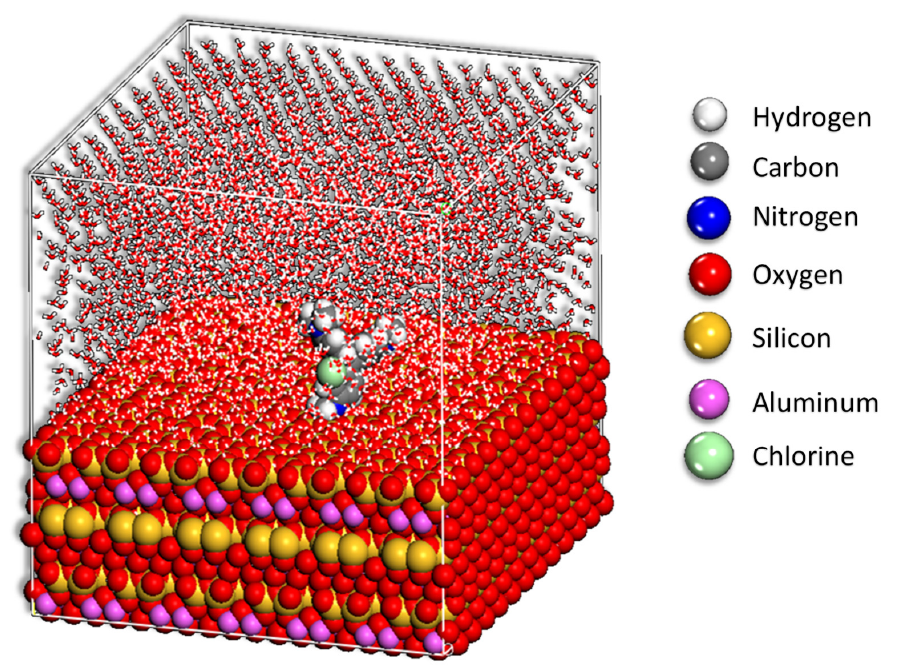
Figure 12. Final MD pose of the lowest adsorption configurations for the MV in the simulated corrosion media on the HNC surface PBC model.